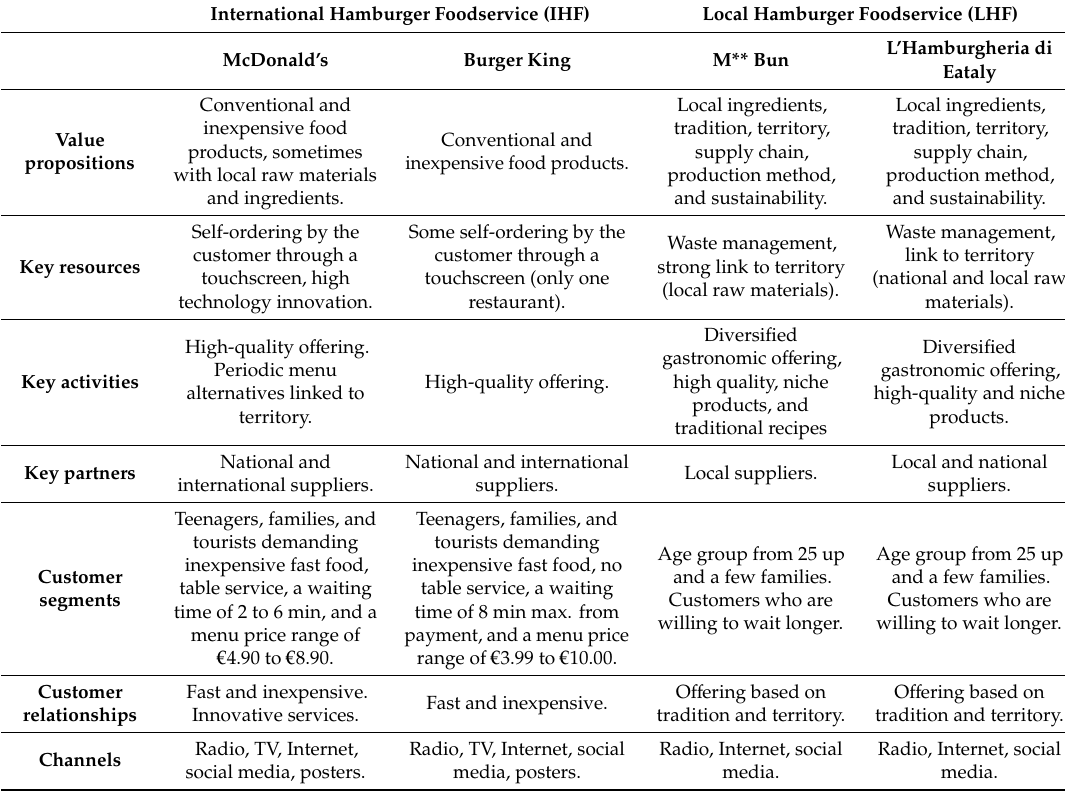
Table 1. Comparison of the four investigated hamburger